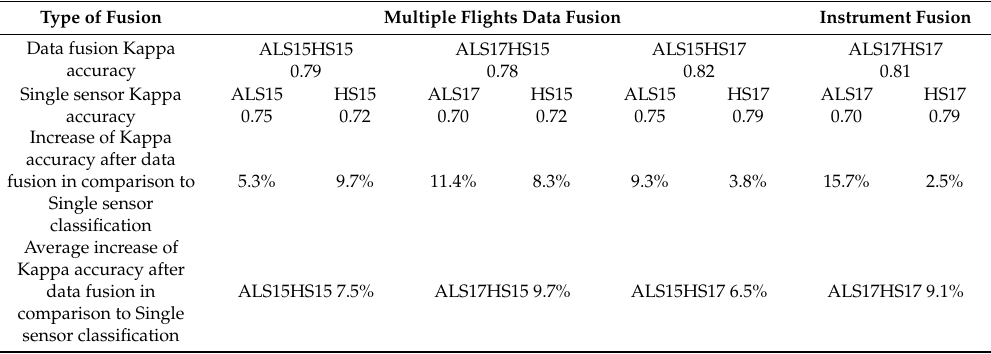
Table 6. Accuracy gains between average single sensor Kappa accuracy and data fusion Kappa accuracy. Subtracted values are the average of 1000 classifications with randomly varying training and validation